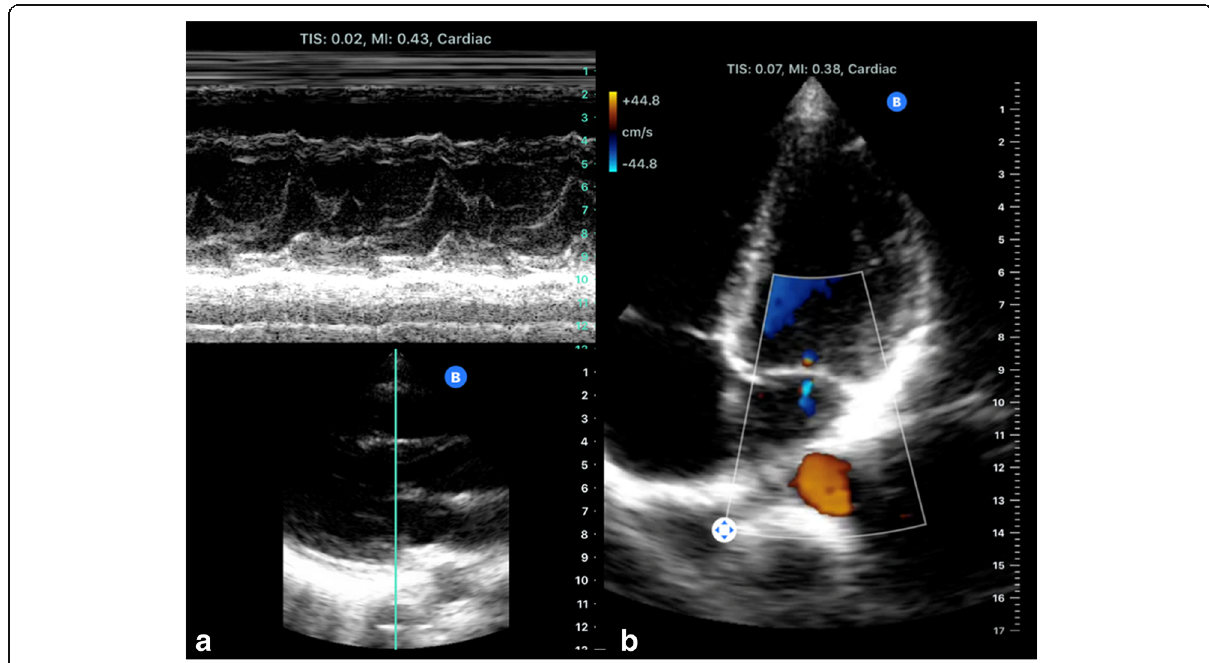
Fig. 8 Butterfly ’ s iQ emulate phased transducers: Cardiac imaging including M-Mode ( a ) and four chamber view with colour Doppler ( b )